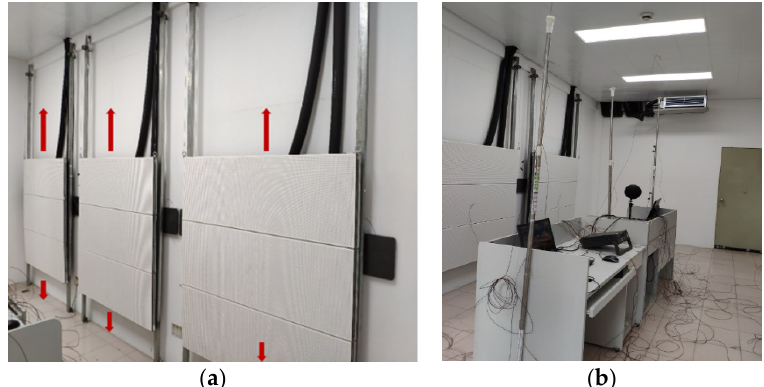
Figure 2. ( a ) Modular radiant terminal; ( b ) Field test.